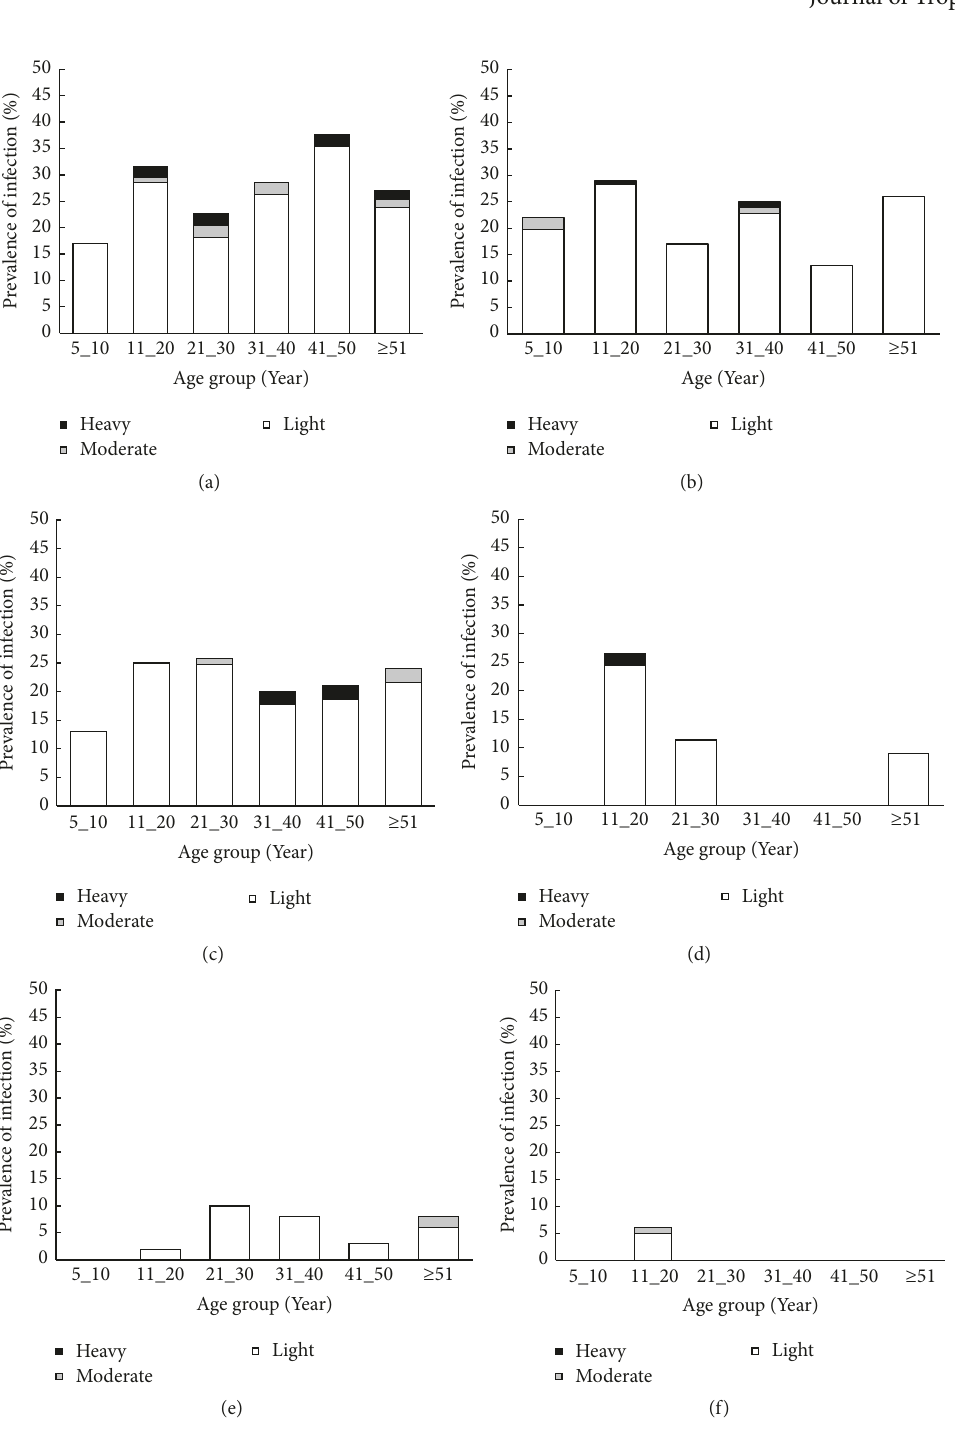
Figure 3: Prevalence and intensity categories of hookworm infection, stratified by age groups in eastern settings of Cˆote d’Ivoire. (a) Soribadougou. (b) Pokoukro. (c) Prakro. (d) Yaobabikro. (e) Yadio. (f)